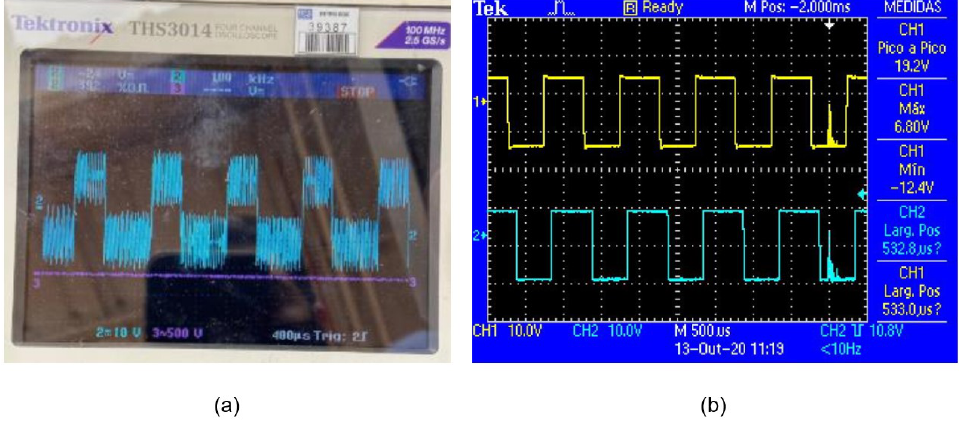
Figure 10. Communication signal comparison. ( a ) BYD charging station with BYD bus. ( b ) WEG charging station with Volvo hybrid XC60 (yellow signal) and Chevrolet EV Bolt (blue